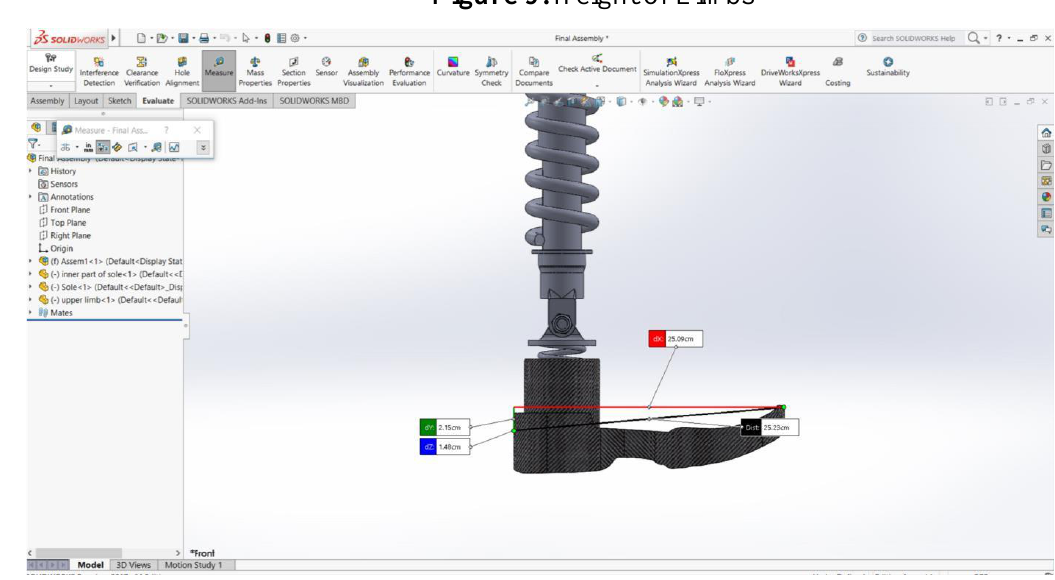
Figure 10. Length of Sole